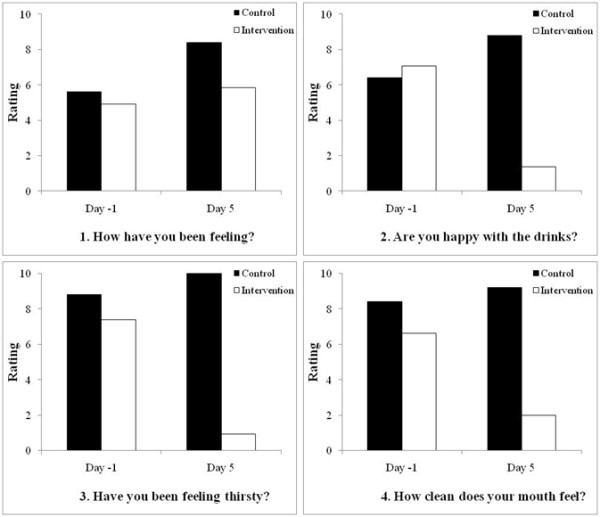
Results of the quality of life surveys for patients in the control and intervention groups. Patients were asked a series of four simple questions related to quality of life on the final day of the pre-intervention period (Day -1) and on the final day of the post-intervention period (Day 5). Scores represent the mean of each group on the basis of the Wong and Baker, 1986, faces rating chart which assesses pain on a zero to ten scale with an increment of two; therefore, the lower scores represent lower pain or greater happiness (0 is no pain, represented by a smiley face and 10 is worst pain imaginable, represented by sad weeping face). It is interesting to note the remarkable differences in the two groups when asked a specific question (questions two to four), with the intervention group showing much greater satisfaction than the control group. In contrast, the difference is much smaller between the two groups, with the control group indicating slightly more positive responses than the intervention group, for the more general question one.